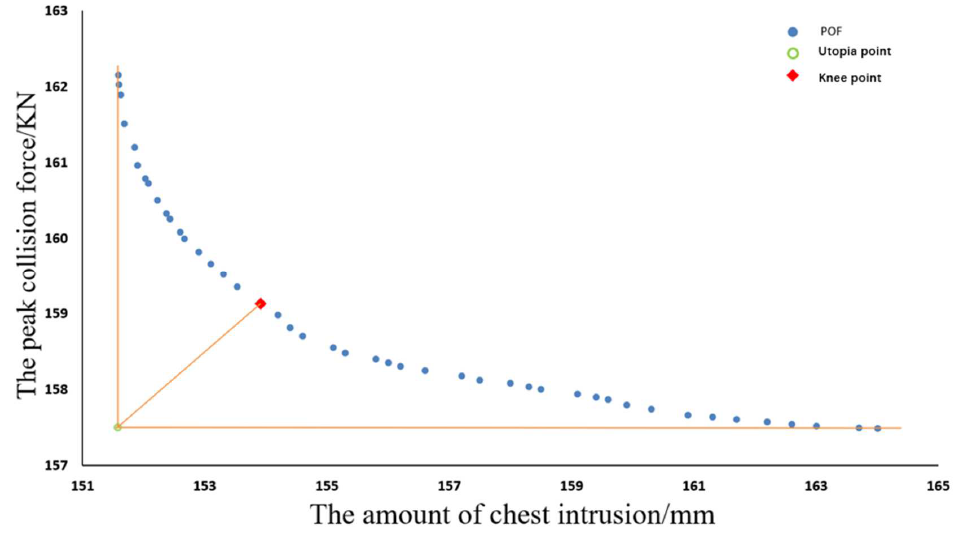
Figure 18. Pareto optimal approximate front and Knee point of multi-objective optimization design for vehicle-side crash. Table 5. Comparison of whole-vehicle crash worthiness before and after optimization.